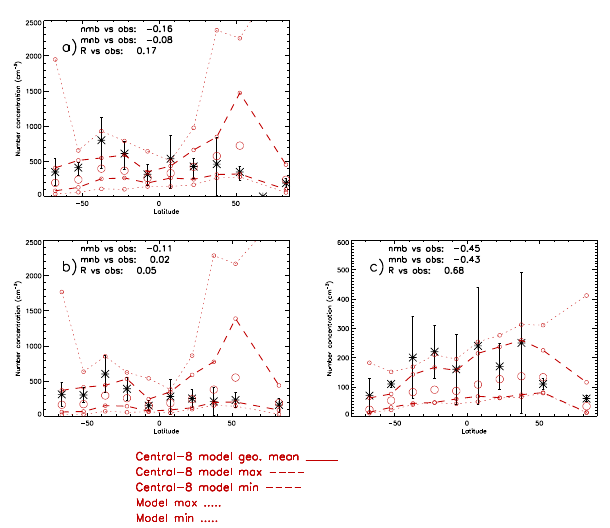
Figure 21. Meridional variation of central-model simulated N 10 , Aitken mode and accumulation mode particle concentrations in the marine boundary layer, compared with a compilation of observa- tions from cruise measurements (Heintzenberg et al., 2000). The ob- served values were derived from fitting modes to the full size distri- butions, whereas the model Aitken and accumulation mode concen- trations are here calculated as mean N 10 − N 100 and N 100 respec- tively, averaging over all marine grid boxes in each latitude band. The solid line shows the geometric mean of the central-8 models, dashed lines indicate the maximum and minimum of the central-8, while dotted lines indicate the maximum and minimum over all 12